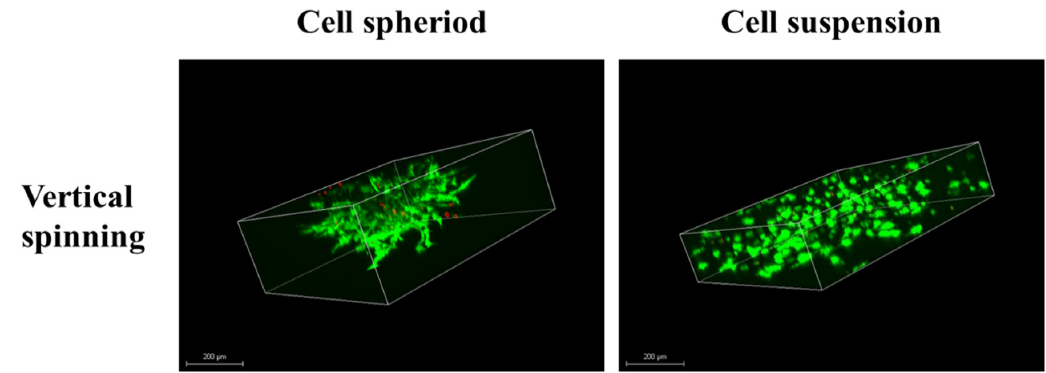
Figure 1. Three-dimensional live/dead staining image of human adipose-derived stem cells (hASCs) in the 3D hydrogel system after 7 day incubation (green: live and red: dead), scale bar = 200 mm.